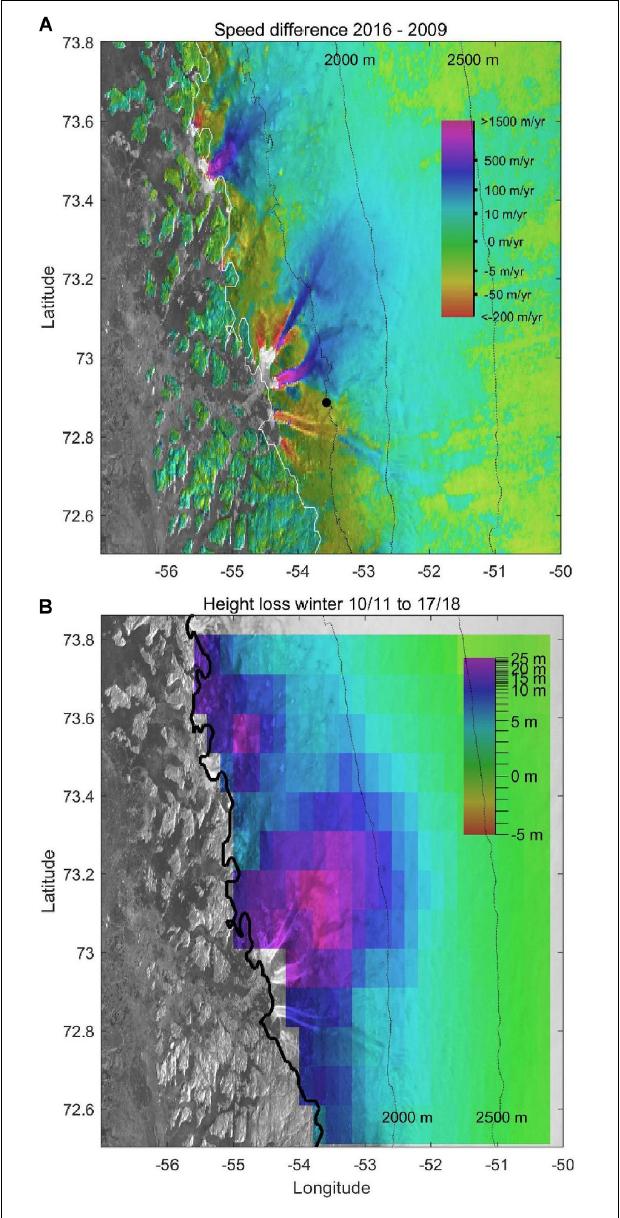
FIGURE 4 | (A) The difference in ice speed between the winter of 2016/17 and 2009/10 is shown as a color overlay superimposed on a Radarsat mosaic image of the ice sheet. The position of the UPE-U AWS is shown by the black dot. (B) Height change between the winter/spring of 2010/11 and the same period in 2017/18 again illustrated as color on the Radarsat image.